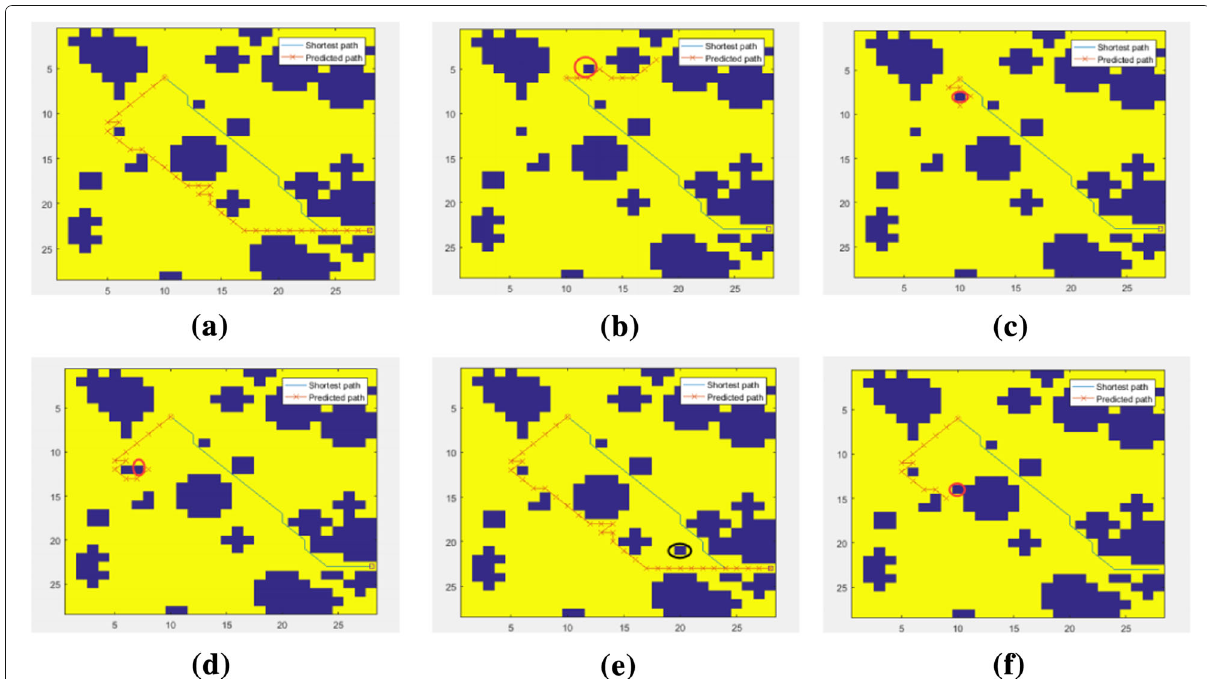
Fig. 8 Examples for adversarial examples successfully attack. The examples show that the method proposed in this paper do have ability to find vulnerabilities under VIN pathfinding, and thus interfere the performance of agent automatic pathfinding. a Sample of testing set. b Available Obstacle 1. c Available Obstacle 2. d Available Obstacle 3. e Available Obstacle 4. f Available Obstacle